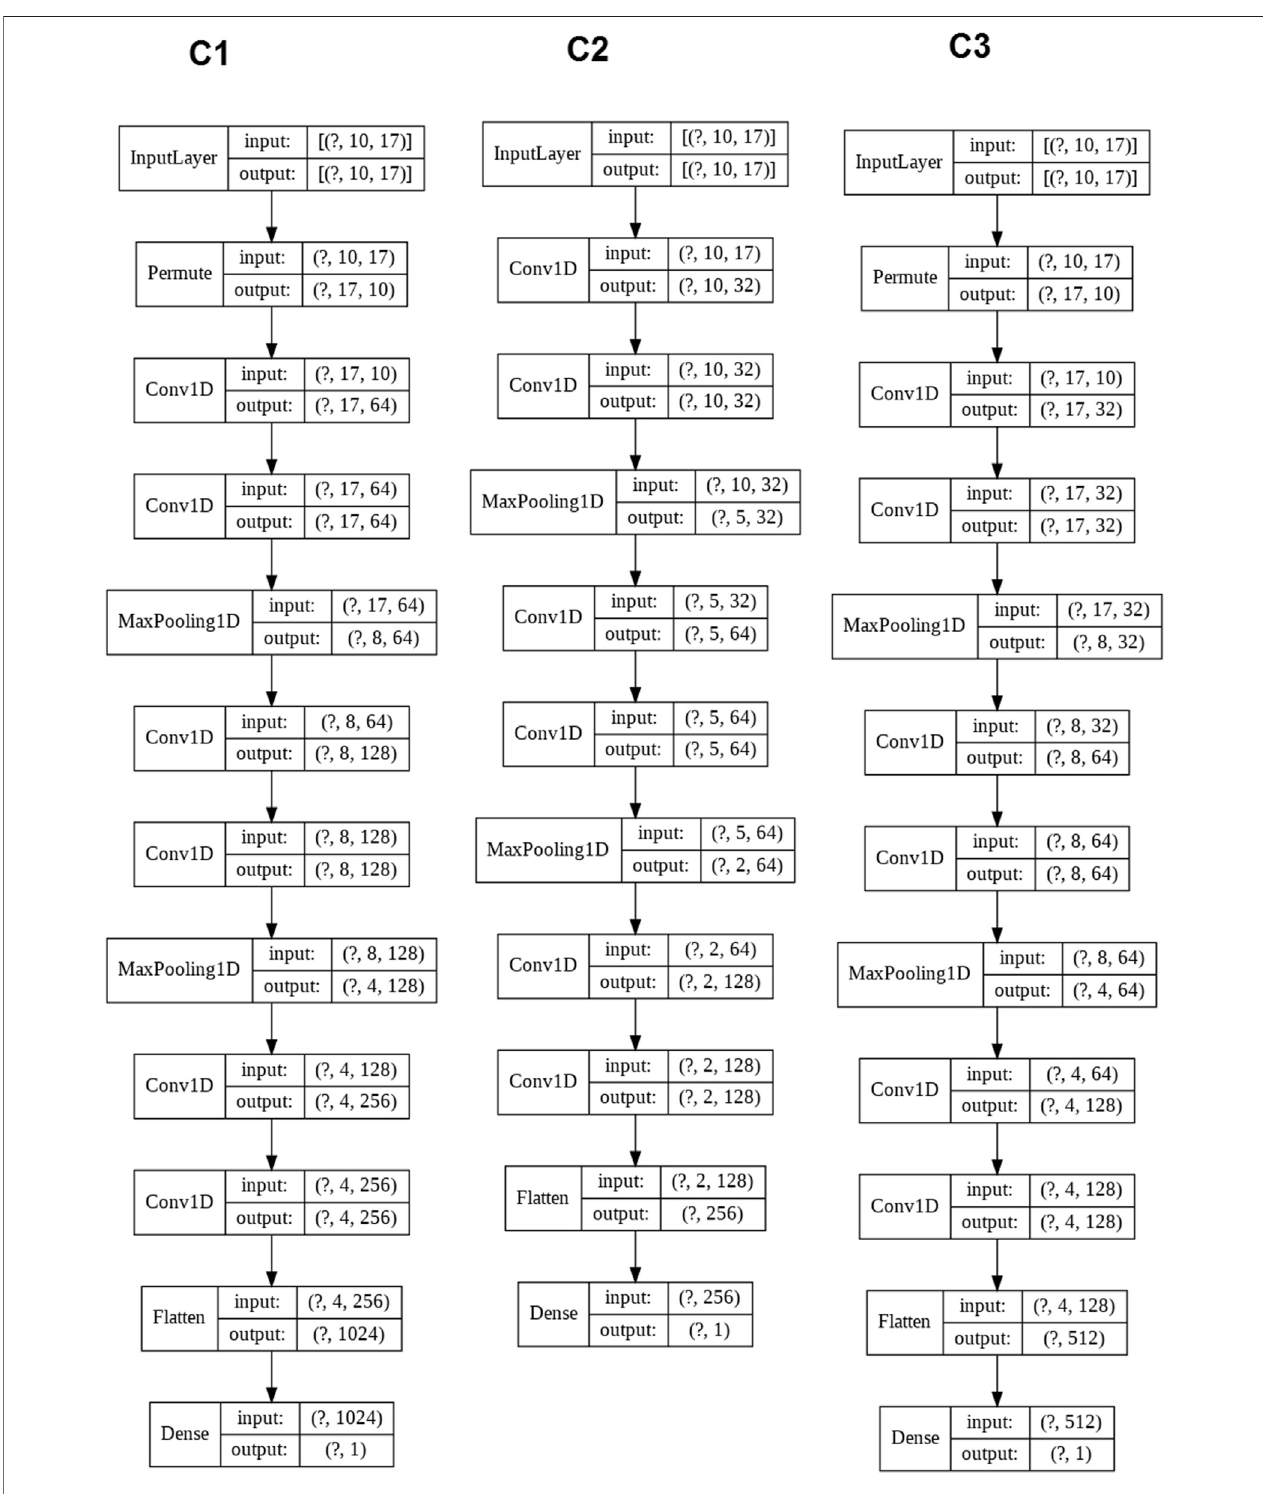
FIGURE 5 | Architectures of convolution neural